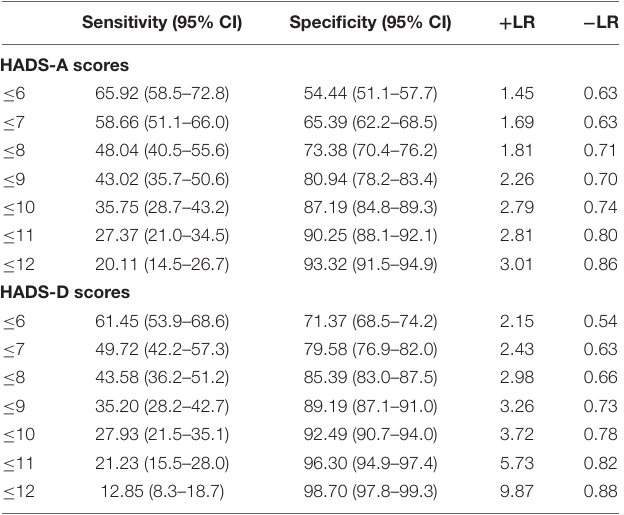
TABLE 6 | Psychometric properties of HADS-A and HADS-D at different cut-off scores (ROC analysis). Sensitivity (95% CI) Specificity (95% CI)